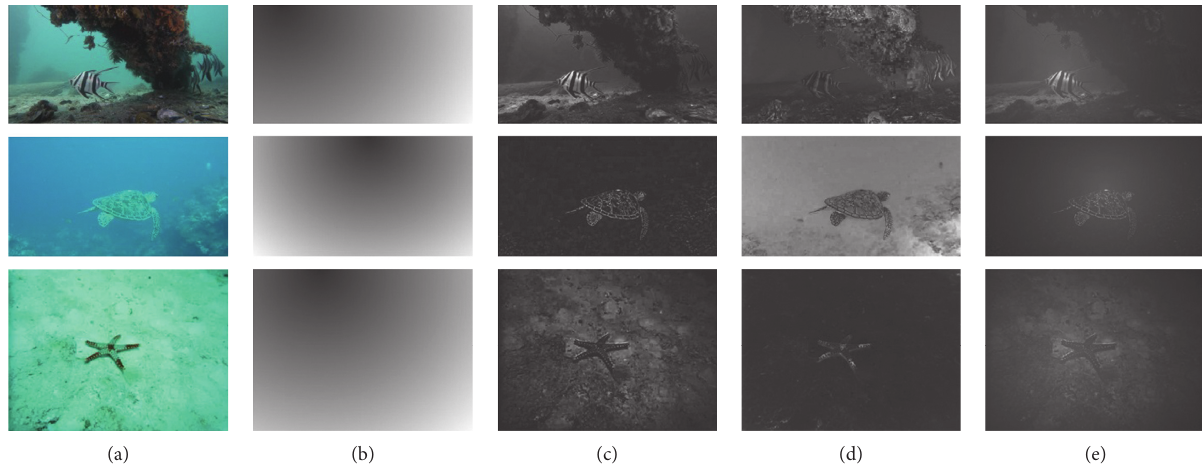
Figure 3: Optical collimation. (a) Original image. (b) Irradiation-position relation. (c) Red-channel contrast. (d) Channel variation. (e) Map of S